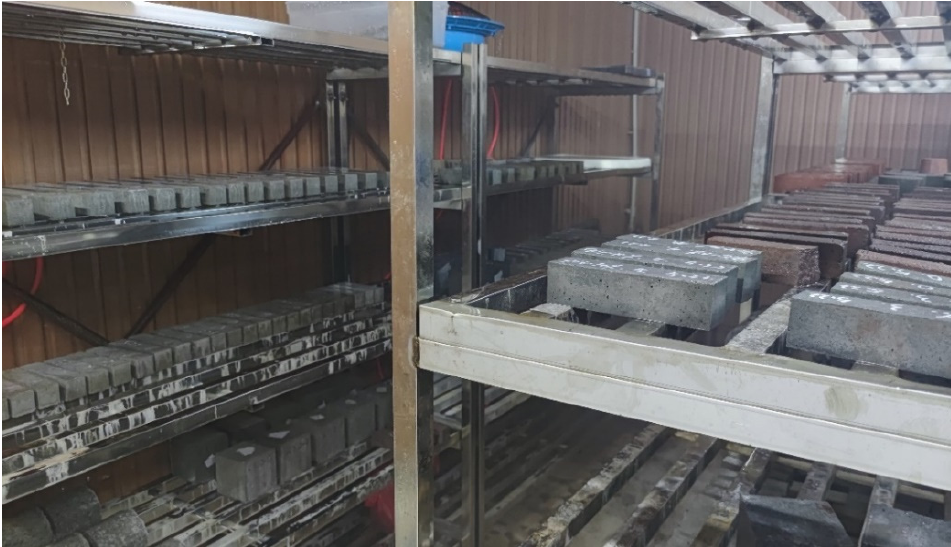
Figure 3. Specimens were cured for 7 days and 28 days in the standard curing room.